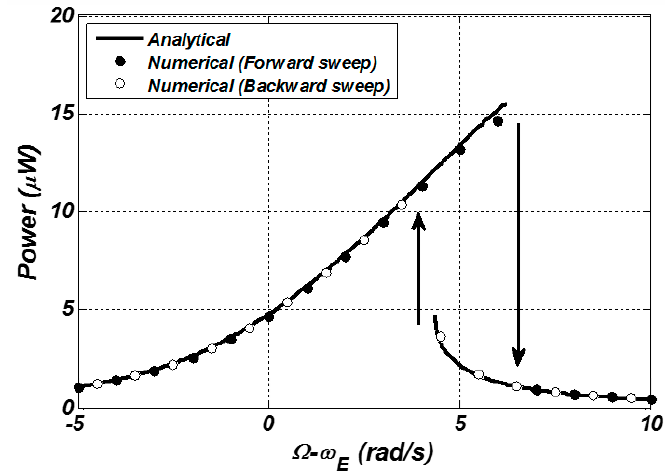
Figure 8. Variation of extracted power with deviation of excitation frequency from the natural one ( A Base = 0.2 g , R = 2 k Ω ).